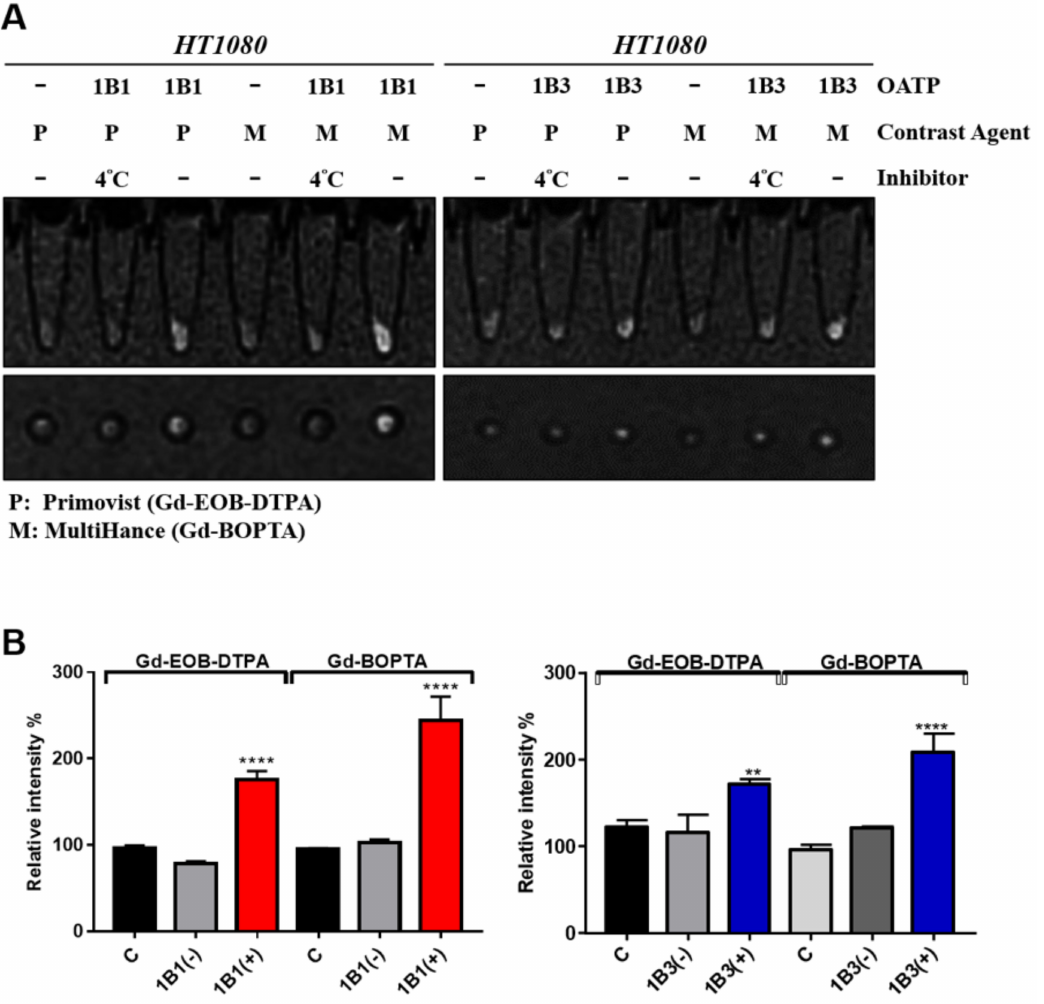
Figure 5. In vitro uptake of MRI contrast agents in HT1080. ( A ) OATP-expressing and untransduced HT1080 cells were treated with MRI contrast agents. The inhibitor group was incubated at 4 ◦ C. After PBS washing three times, cells were scanned with a 1.5-T MRI system. ( B ) The quantitative signal intensity of cell MRI ( n = 3). Error bars show the SEM, and ** and **** represent p < 0.01 and p < 0.0001, respectively. C, control; 1B1, OATP1B1-expressing cells; ( − ), inhibitor group; (+), normal group; P, Primovist; M,